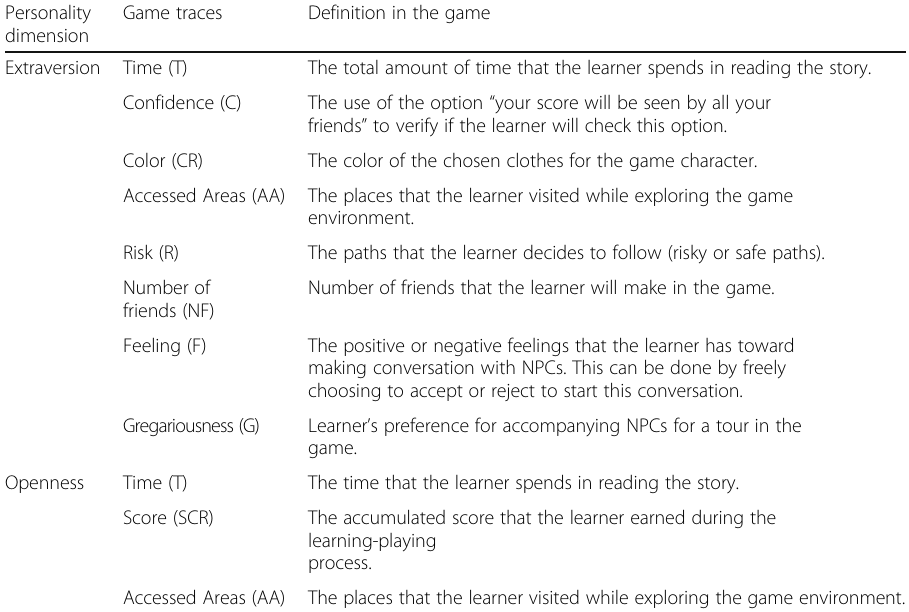
Table 1 The related gaming behavior traces for each personality